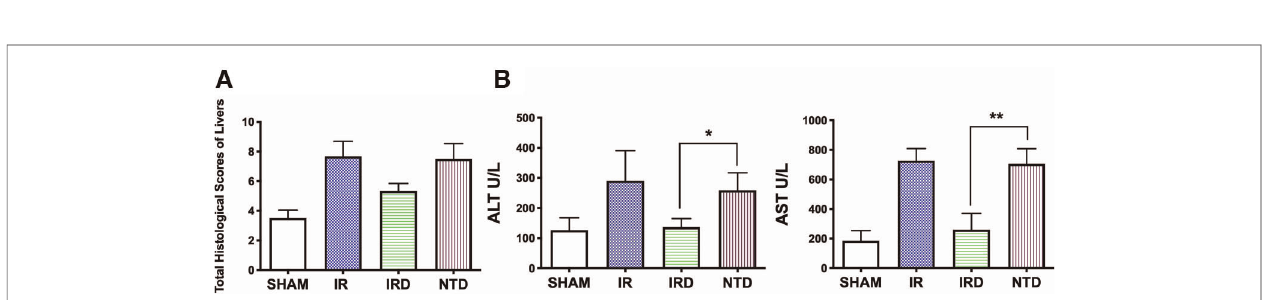
FIGURE 2 | DOR antagonist NTD eliminated the bene fi cial effect of DADLE. ( A ) Suzuki score after a 6- h reperfusion by H&E staining. n =6, * p <0.05 compared with the IR group. ( B ) Serum ALT and AST levels in each group after 6- h reperfusion; n =6, * p <0.05; ** p <0.01. IR, ischemia – reperfusion injury group; IRD, DOR agonist DADLE at 5 mg·kg − 1 treatment group; NTD, DOR antagonist natrindole hydrochloride administered group.